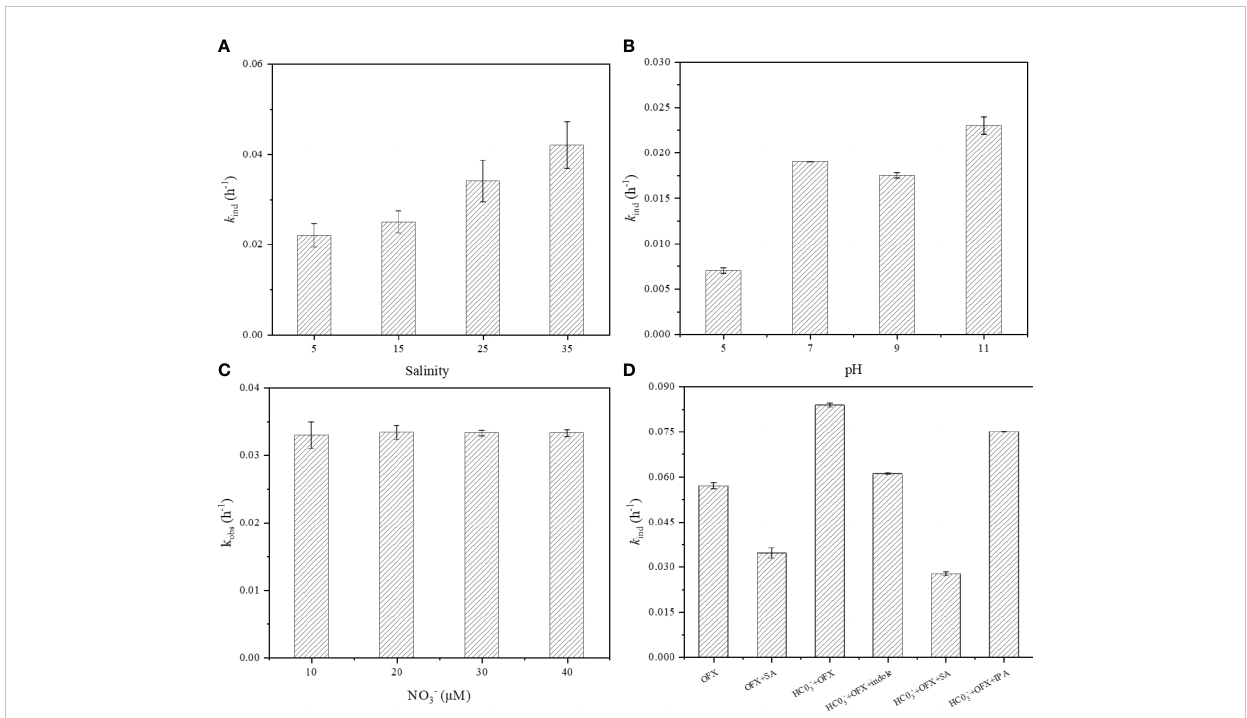
FIGURE 4 The indirect photodegradation rate of OFX at different (A) salinity and (B) pH values, (C) NO 3 − concentrations, and (D) radical quenchers (indole = 200 m M, HCO 3 − = 2 mM, IPA = 100 mM, and SA = 2 mM). All solutions were prepared with JKHA (10 mg C L − 1 ). The data were presented as mean; error bars denote standard deviations (p< 0.05, n = 3). OFX, o fl oxacin; IPA, isopropanol; SA, sorbic